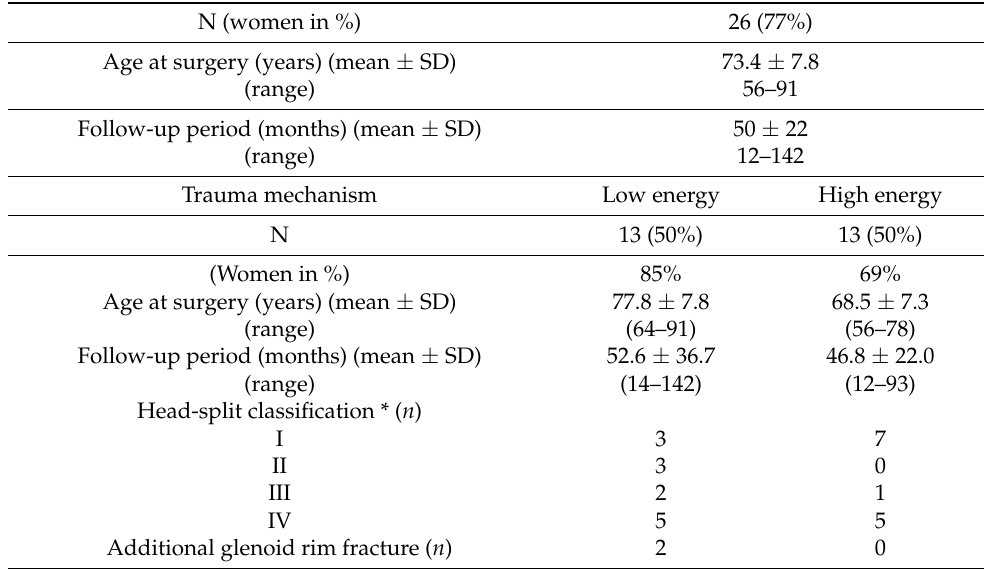
Table 1. Baseline patient demographics.